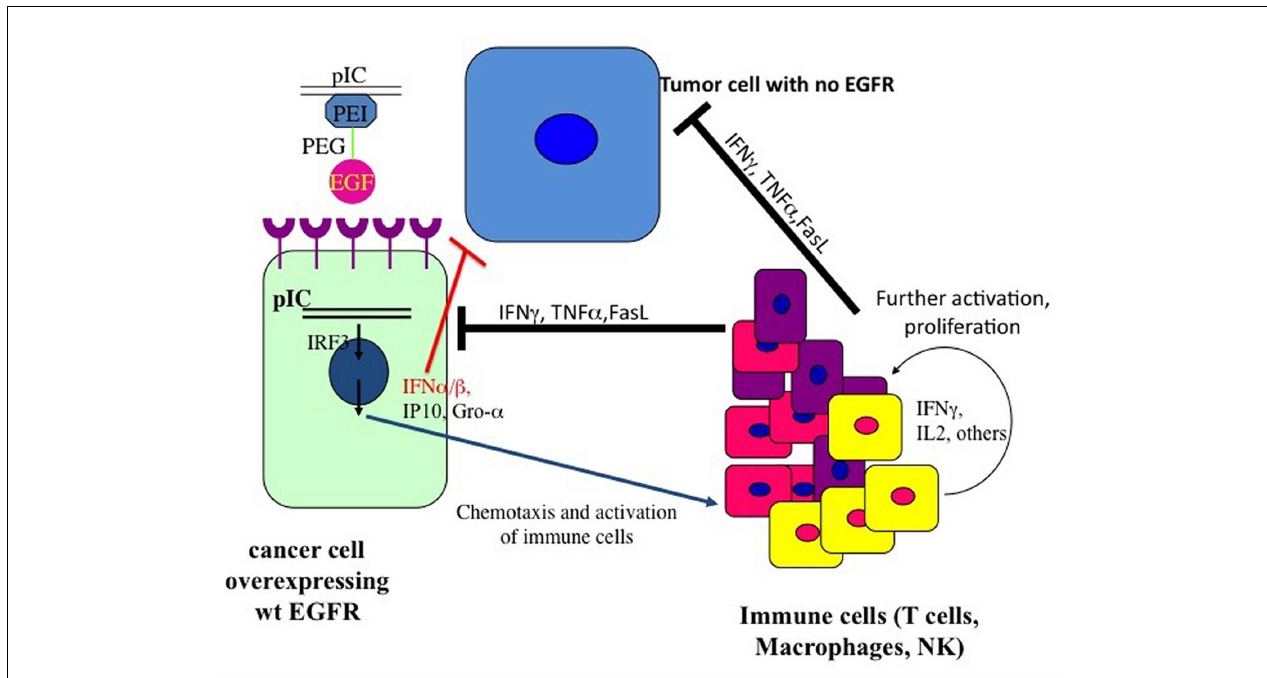
FIGURE 3 |The pattern of the recruitment of the immune system to the tumor. The dsRNA internalized into the tumor cells binds to dsRNA-binding signaling proteins, which then activate a plethora of signaling pathways, leading to the recruitment of immune cells to the tumor as well as to apoptotic programs ( Figure 1